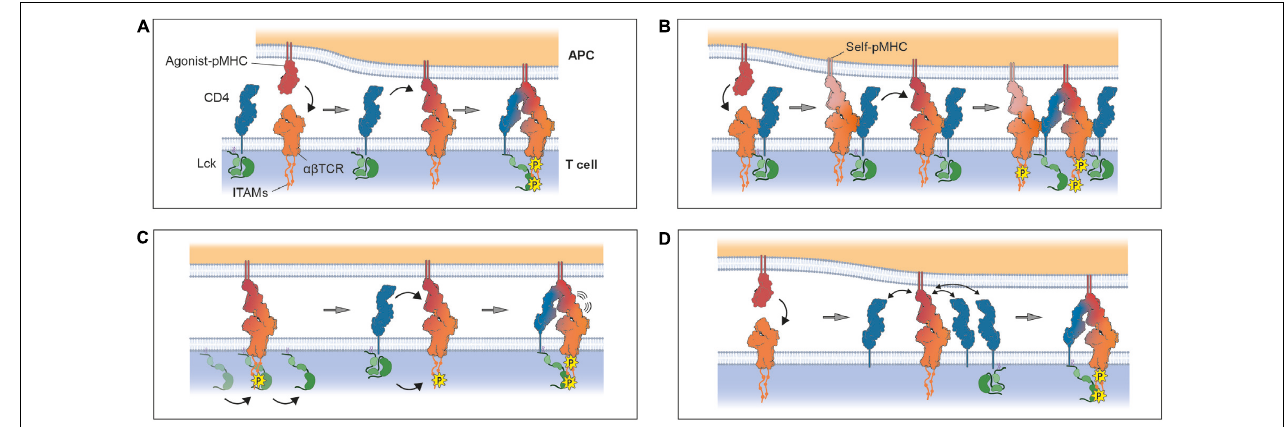
FIGURE 3 | Models for coreceptor function. (A) The Lck recruitment model: coreceptors recruit Lck to cognate pMHC-TCR complexes. (B) The pseudodimer model: coreceptors cross-link agonist-bound TCR to self-bound TCR. (C) The coreceptor recruitment model: ITAMs are incipiently phosphorylated by free Lck prior to recruitment of a coreceptor/Lck complex through SH2 domain-dependent interactions, e.g., between Lck and phosphorylated ITAMs. (D) The coreceptor scanning model: a cognate pMHC-TCR complex scans multiple “empty” coreceptors before encountering coreceptor-bound Lck. Gray arrows denote the passage of time. Only the zeta chain ITAMs are shown for simplicity. Protein models were generated from the crystal structures of TCR/CD3 (PDB ID: 6JXR), CD4 (PDB ID: 1WIQ), HLA-DR1 (PDB ID: 4I5B), and the ternary TCR-pMHC-CD4 complex (PDB ID: